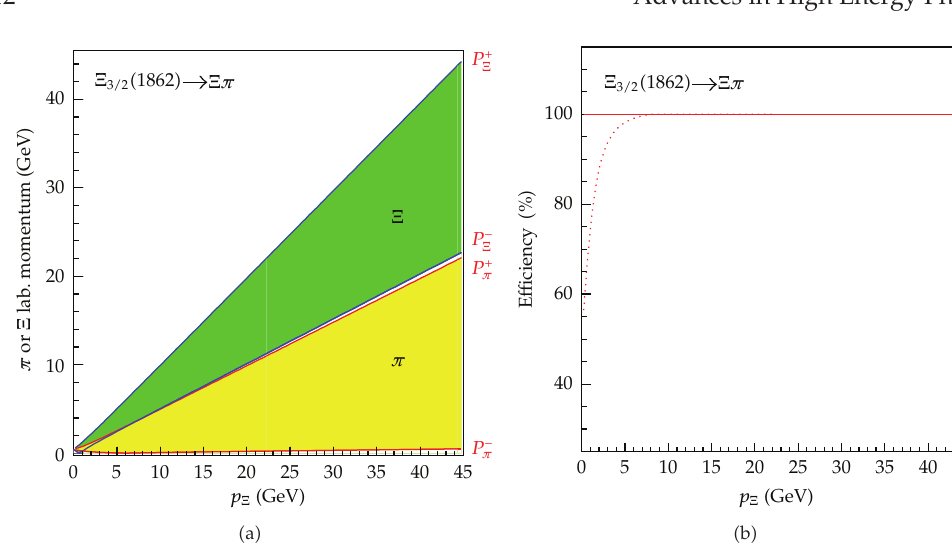
Figure 5: The m -bands and the e ffi ciency of the m - and E -selectors for the Ξ 3 / 2 → Ξ (cid:9) π decay with the Ξ 3 / 2 mass reported by the NA49 collaboration